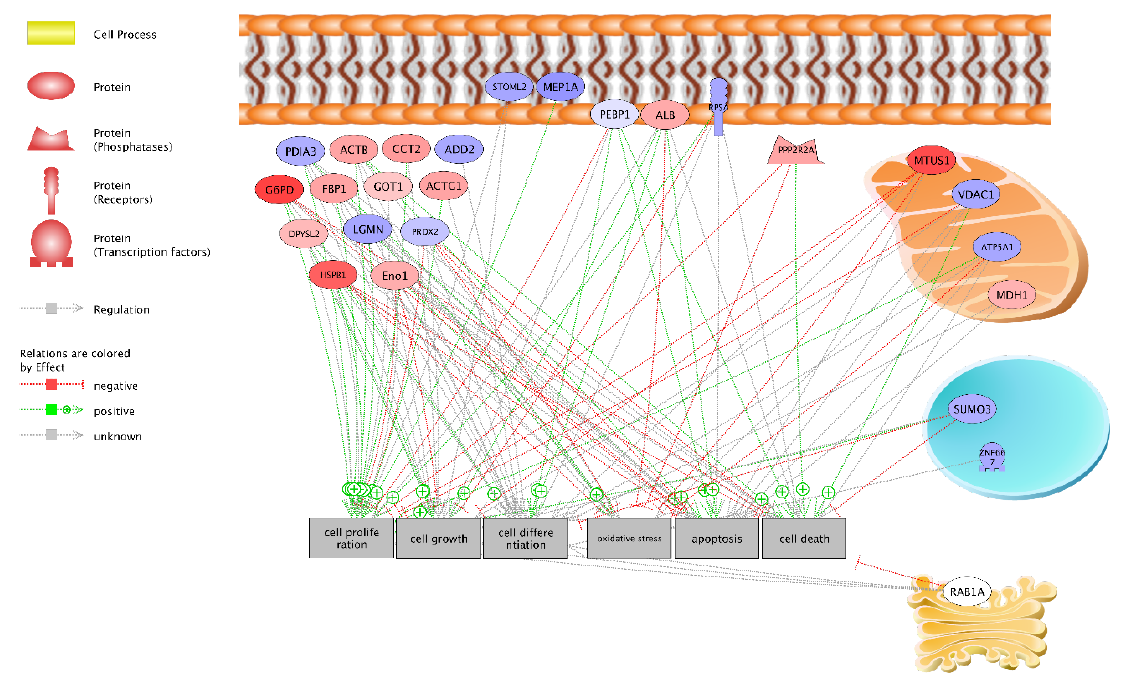
Figure 3. Interaction of proteins 3 days after hyperoxia. Pathway Studio (Elsevier, UK) (green arrow: positive regulation, red arrow: negative regulation).